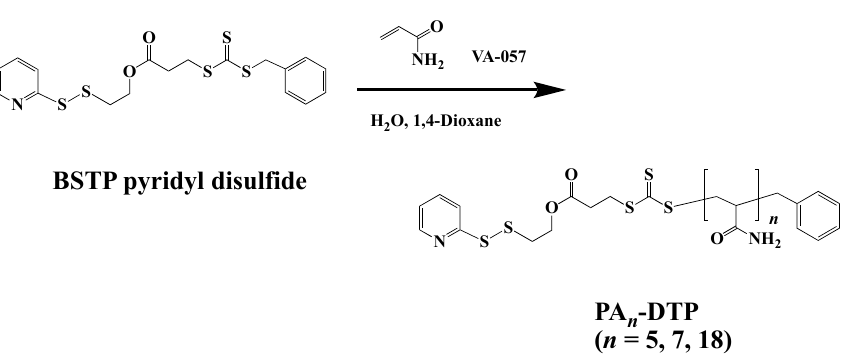
Scheme 1. Synthesis of polyacrylamide (PA) with dithiopyridyl unit (PA n -DTP, n = 5, 7, 18) via RAFT polymerization. Table 1. Summary of M n and PDI off PA n -DTP ( n = 5, 7, and 18). PA n -DTP